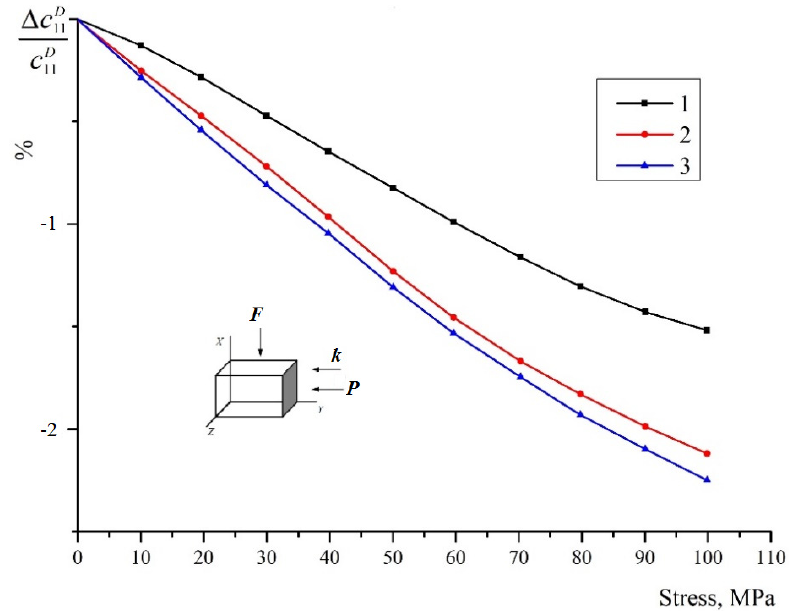
D under the compression across the Z 11